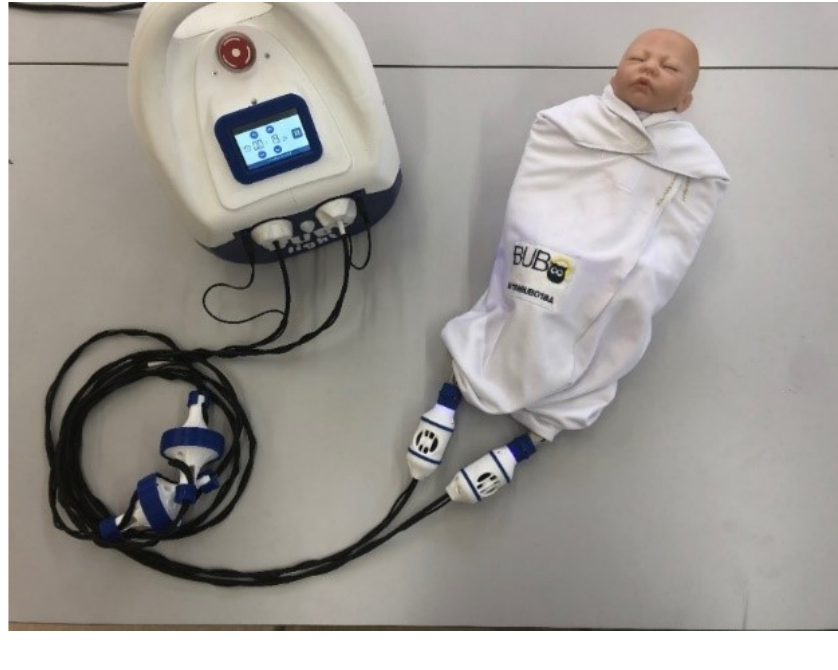
Figure 1. Complete device and light source.